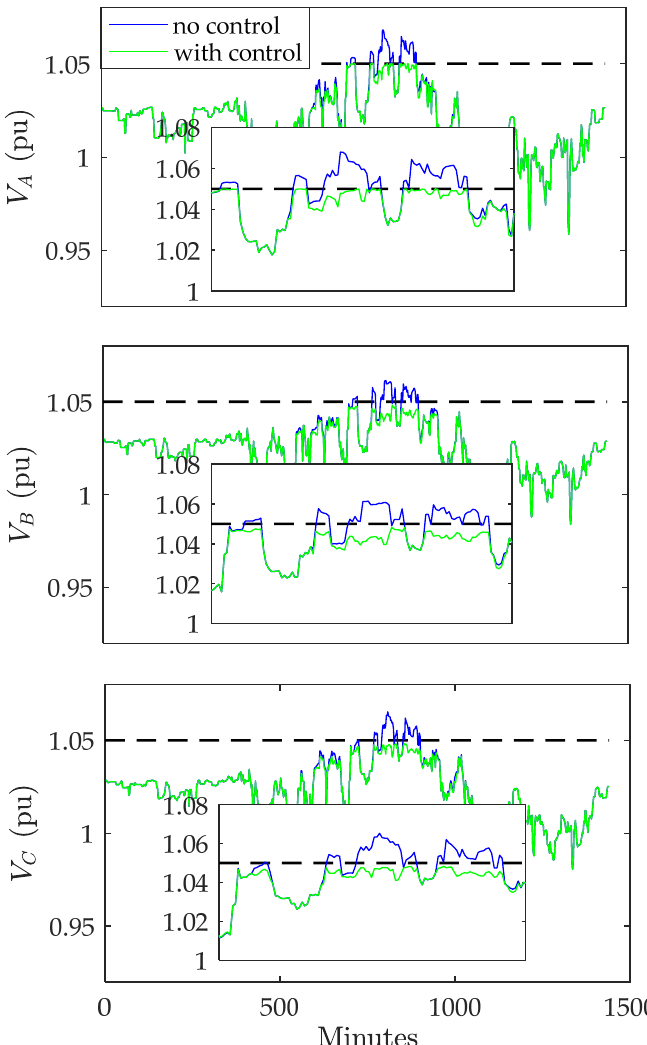
Figure 13. Voltage on lateral 1 without and with control.